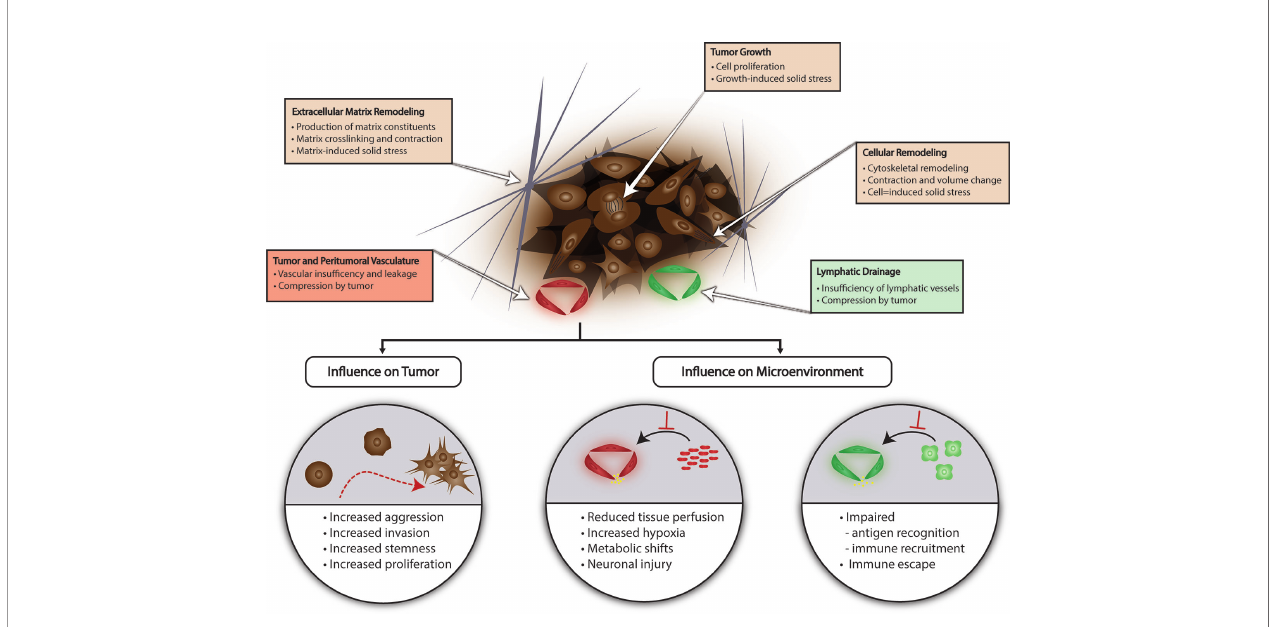
FIGURE 1 | Tissue Mechanics in Glioma. Several factors contribute to generation of solid stress in the glioma microenvironment including lymphatic or vascular insuf fi ciency, tumor growth, and ECM or cellular remodeling. Solid stress can promote glioma aggression and create a microenvironment conducive for immune escape and BTIC selection. ECM, extracellular matrix; BTIC, brain tumor-initiating